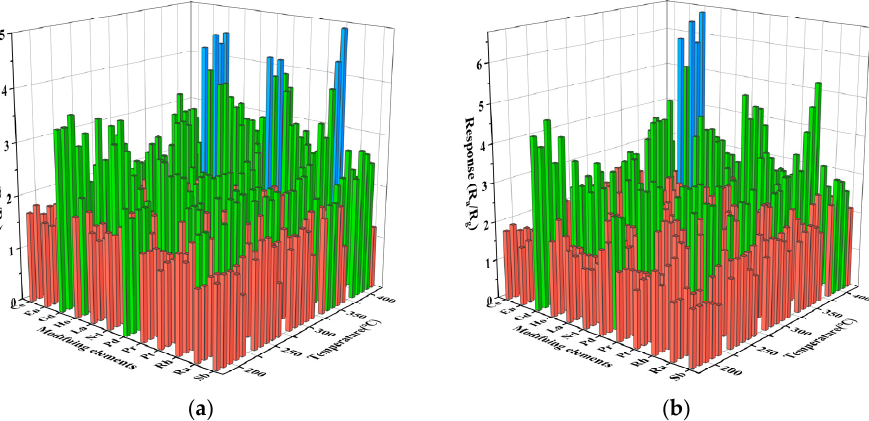
Figure 4. Characteristics of surface-modified In 2 O 3 gas sensor for 50 ppm gasoline and diesel volatile compounds at 200–400 °C. ( a ) Gasoline; ( b ) diesel.